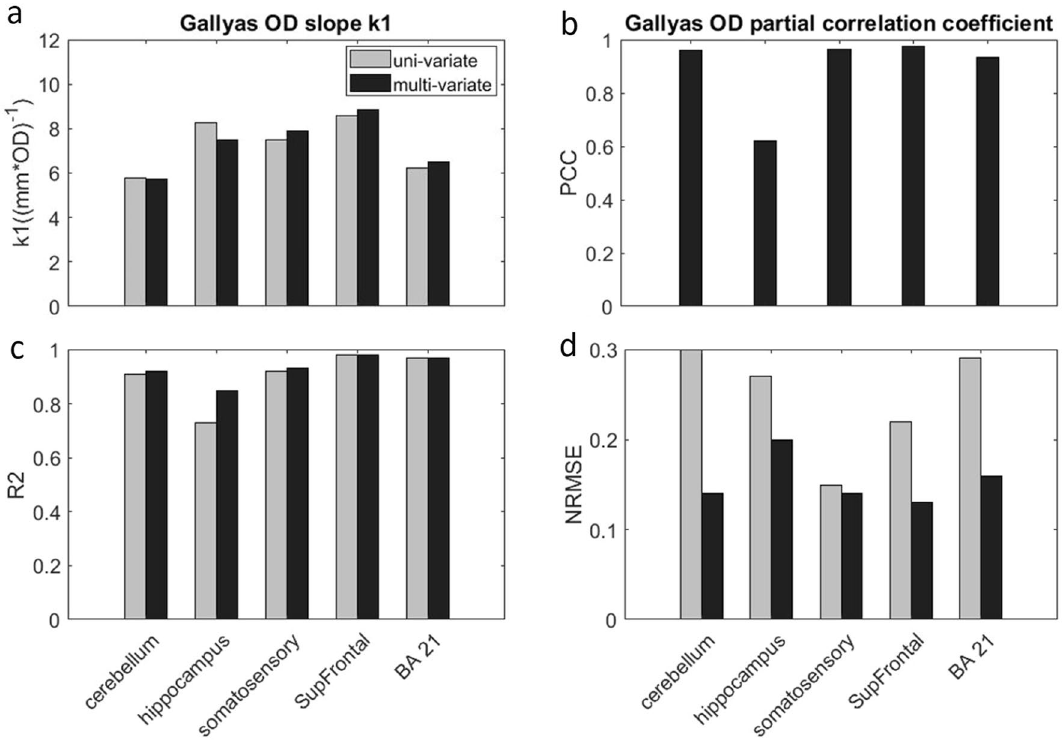
Figure 3. Multivariate regression of µ s vs Gallyas OD and COPA (black bars), compared against univariate regression where only Gallyas OD is considered (grey bars). (a) Gallyas OD slope k 1 of 5 brain regions resulted from univariate regression and multivariate regression. From left to right: cerebellum, hippocampus, somatosensory, SupFrontal and BA21. (b) Correlation coefficient with Gallyas OD in univariate and partial correlation coefficient (PCC) in multivariate regression. (c) R 2 of Pearson’s correlation in univariate and multivariate regressions. (d) Normalized root mean square error (NRMSE) of univariate and multivariate